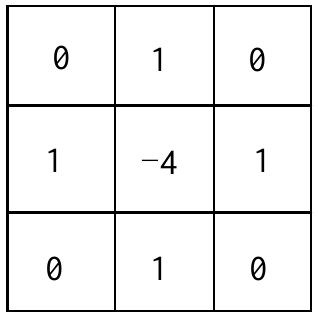
Figure 2. Template of the Laplace